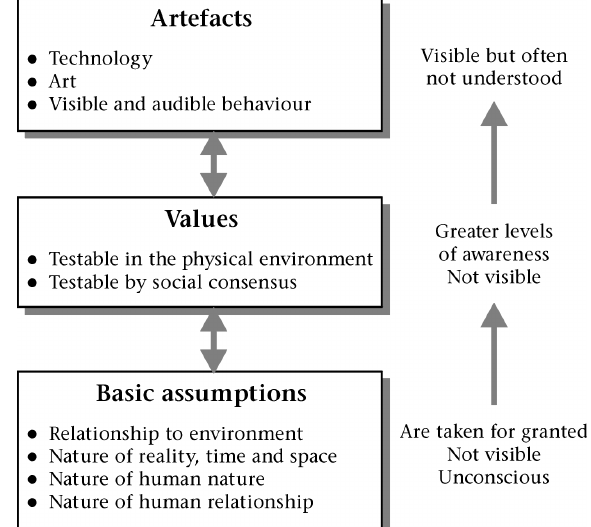
Figure 1: Schein’s Levels of Culture Adapted from Schein (1985,